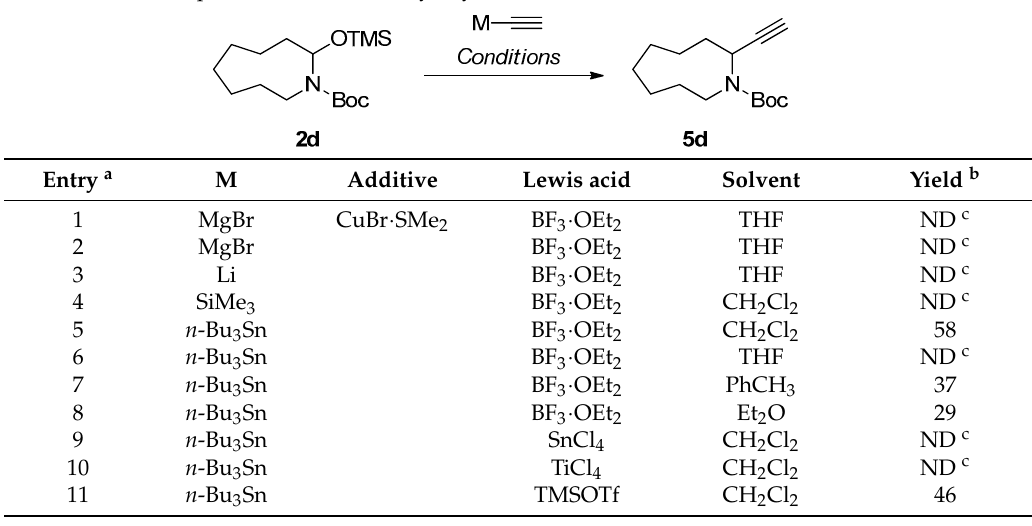
Table 2. Optimization of the acetylenylation conditions for N , O -acetal TMS ethers.